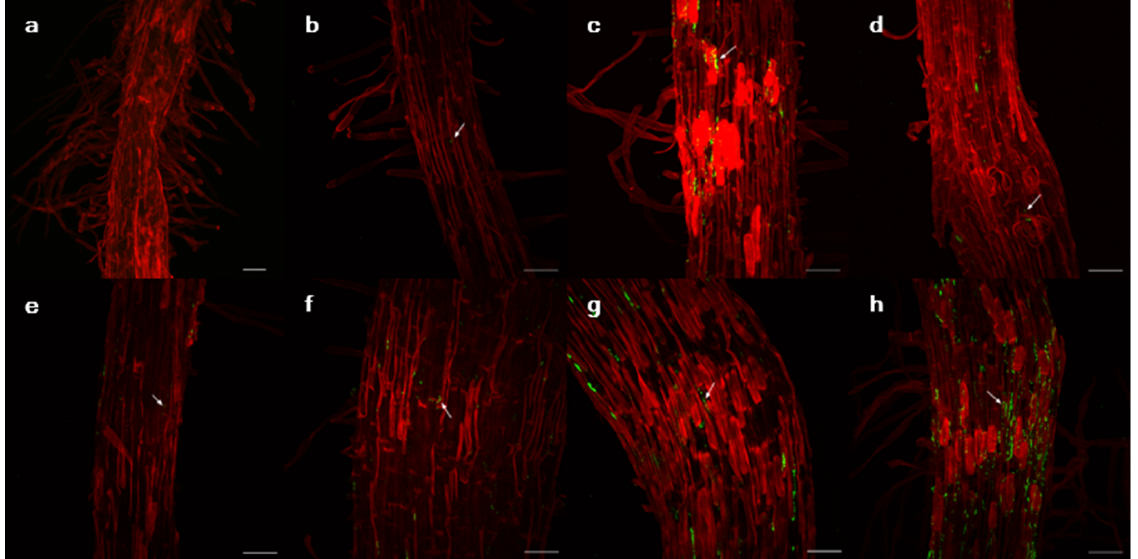
Figure 3. Images of the root tissues of Lactuca serriola genotype P1 with GFPuv-transformed isolates using confocal microscopy. The plant cell wall and isolates are indicated by red and green, respectively. ( a ) Uninfected control, ( b ) Pantoea septica YJ1, ( c ) Kosakonia cowanii YJ4, ( d ) Erwinia tasmaniensis YJ6, ( e ) K. cowanii SD1, ( f ) C. dublienesis subsp. lausanneisis MS26, ( g ) K. cowanii GG1, ( h ) P. ananatis GG19. Scale bar: 50 µm.